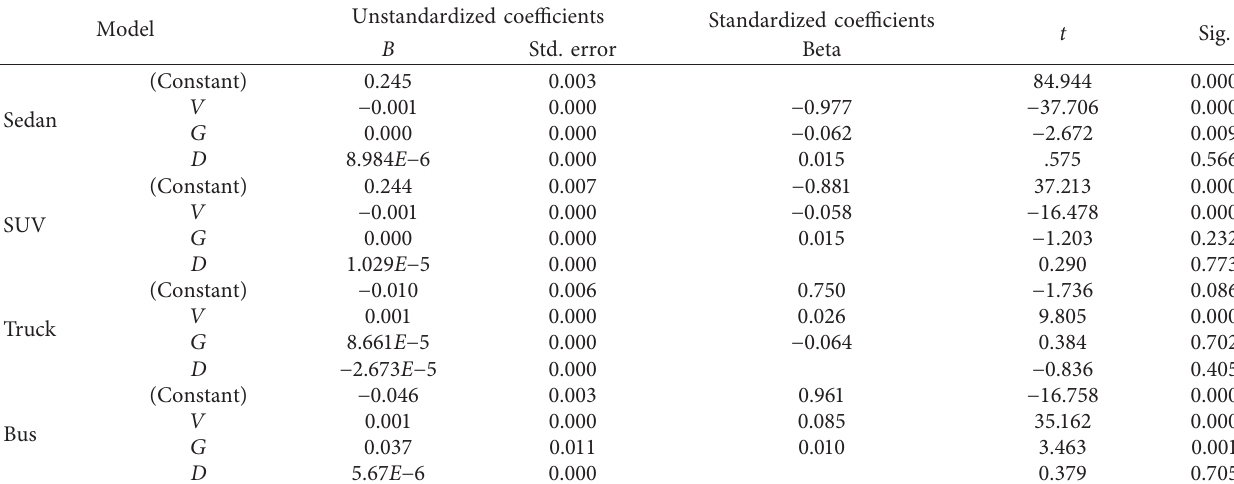
Table 4: Model’s coefficients for vehicle’s lateral friction coefficient.